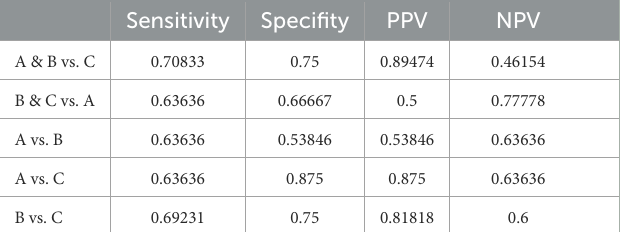
TABLE 2 Results of classification performed using the test